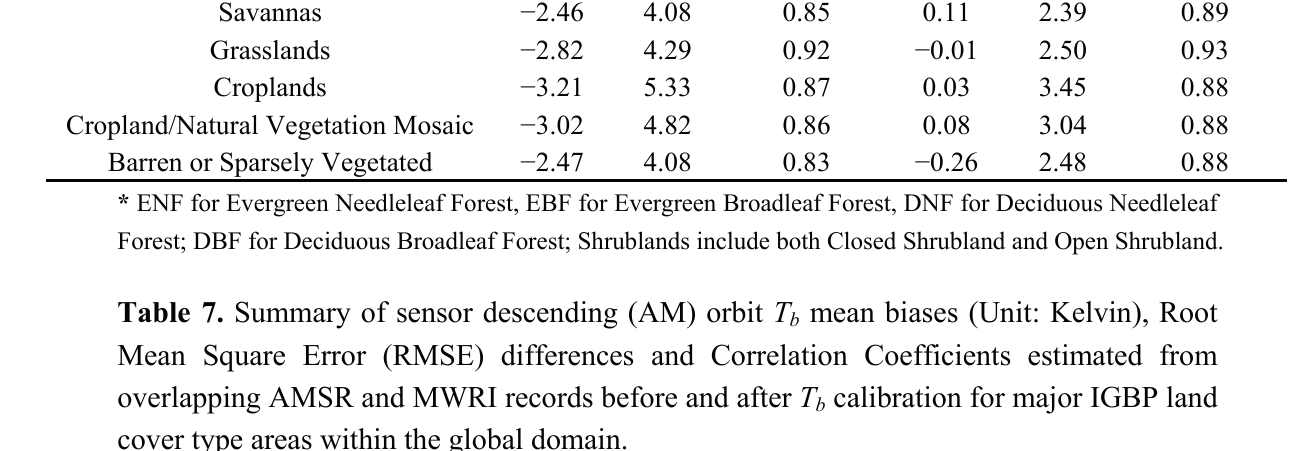
mean biases (Unit: Kelvin), Root b calibration for major IGBP land b